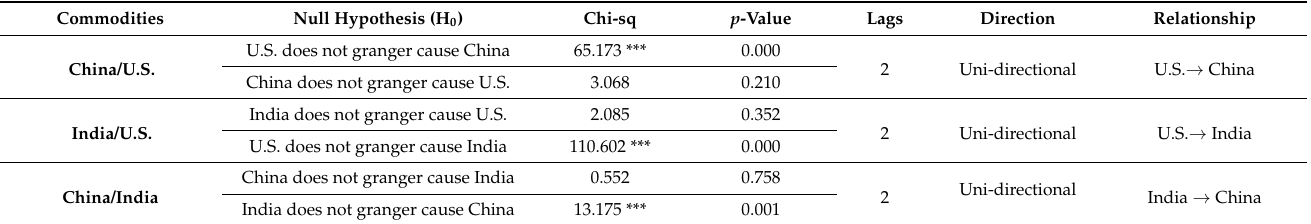
Table 8. Estimates of Toda–Yamamoto Granger Causality Test (First Sub-Period).